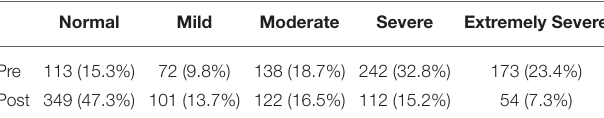
TABLE 3 | Classification of stress symptoms pre- and post-intervention (% of participants in each classification using DASS-21 stress scale).